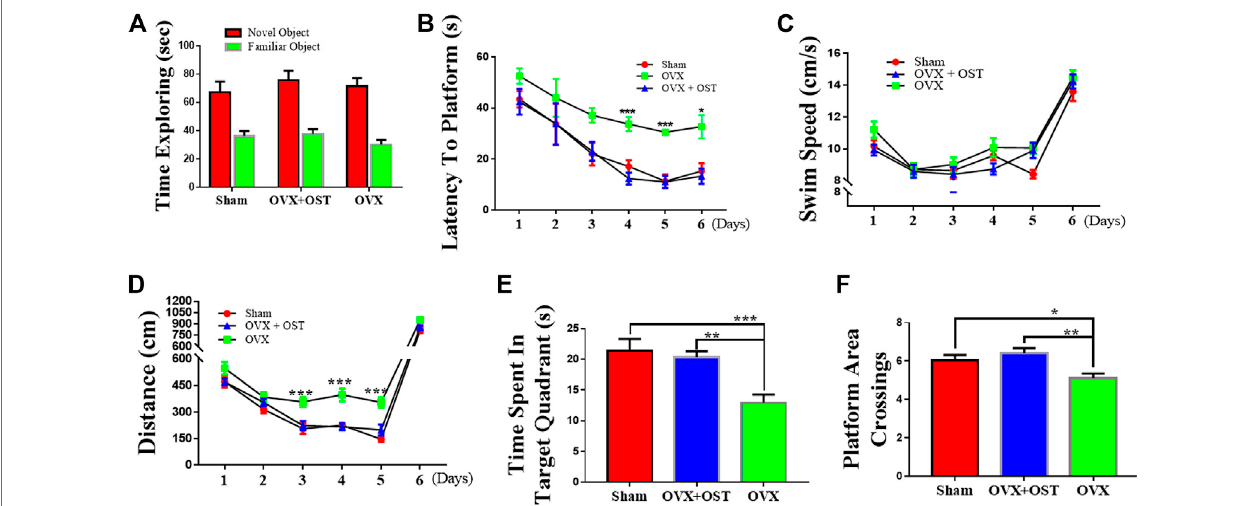
FIGURE 3 | Effects of osthole (OST) on recognition memory (A) in the novel object recognition Test (NORT), and spatial learning and memory in Morris Water Maze (MWM) test (B – F) in OVX mice. The NORT showed that OVX did not lead to impairment in short-term memory as the time spent in exploring the novel object was not different between the groups (A) . (B – F) OVX mice showed an increase in latency (spent more time) in fi nding the platform during the training days (days 3 – 5), whereas treatment with OST did not alter latency in fi nding the platform (B) . OVX and OST did not have any effect on the swim speed among the three groups (C) . OVX mice traveled more distance before fi nding the platform, while treatment with OST reduced the distance traveled during training on day-3 – 5 (D) . OVX mice made fewer platform crossings (E) and spent less time in the target quadrant on the test day 6 (F) . The OVX-mediated decrease in the number of platform area crossings and time spent in target quadrant was reversed by OST treatment (E,F) . Data are represented as mean ± SEM ( n (cid:1) 15). * p < 0.05; ** p < 0.01; *** p < 0.001.